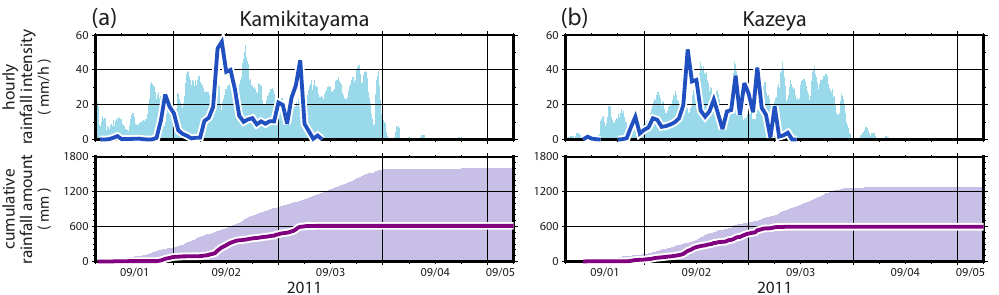
Figure 4. Temporal changes in hourly rainfall intensity (top panels) and cumulative rainfall amount from 06:00UTC, 1 September 2011 (bottom panels) at the Kamikitayama (left panels) and Kazeya (right panels) locations for the AMeDAS observations (bars) and NOPVI results (lines). The locations of these two stations are shown in Fig. 3.